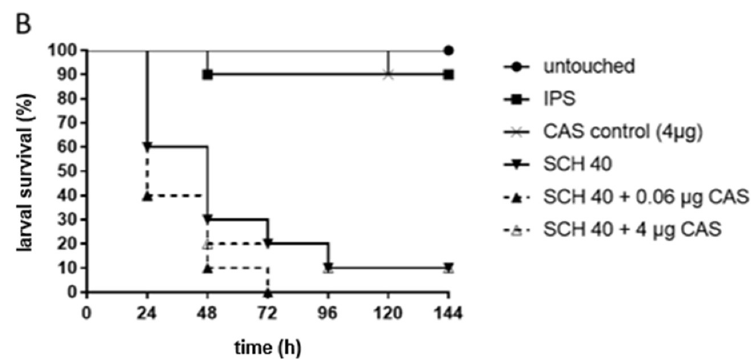
Figure 1. Survival of G. mellonella larvae infected with C. albicans isolates SCH 36 ( A ) or SCH 40 ( B ) and